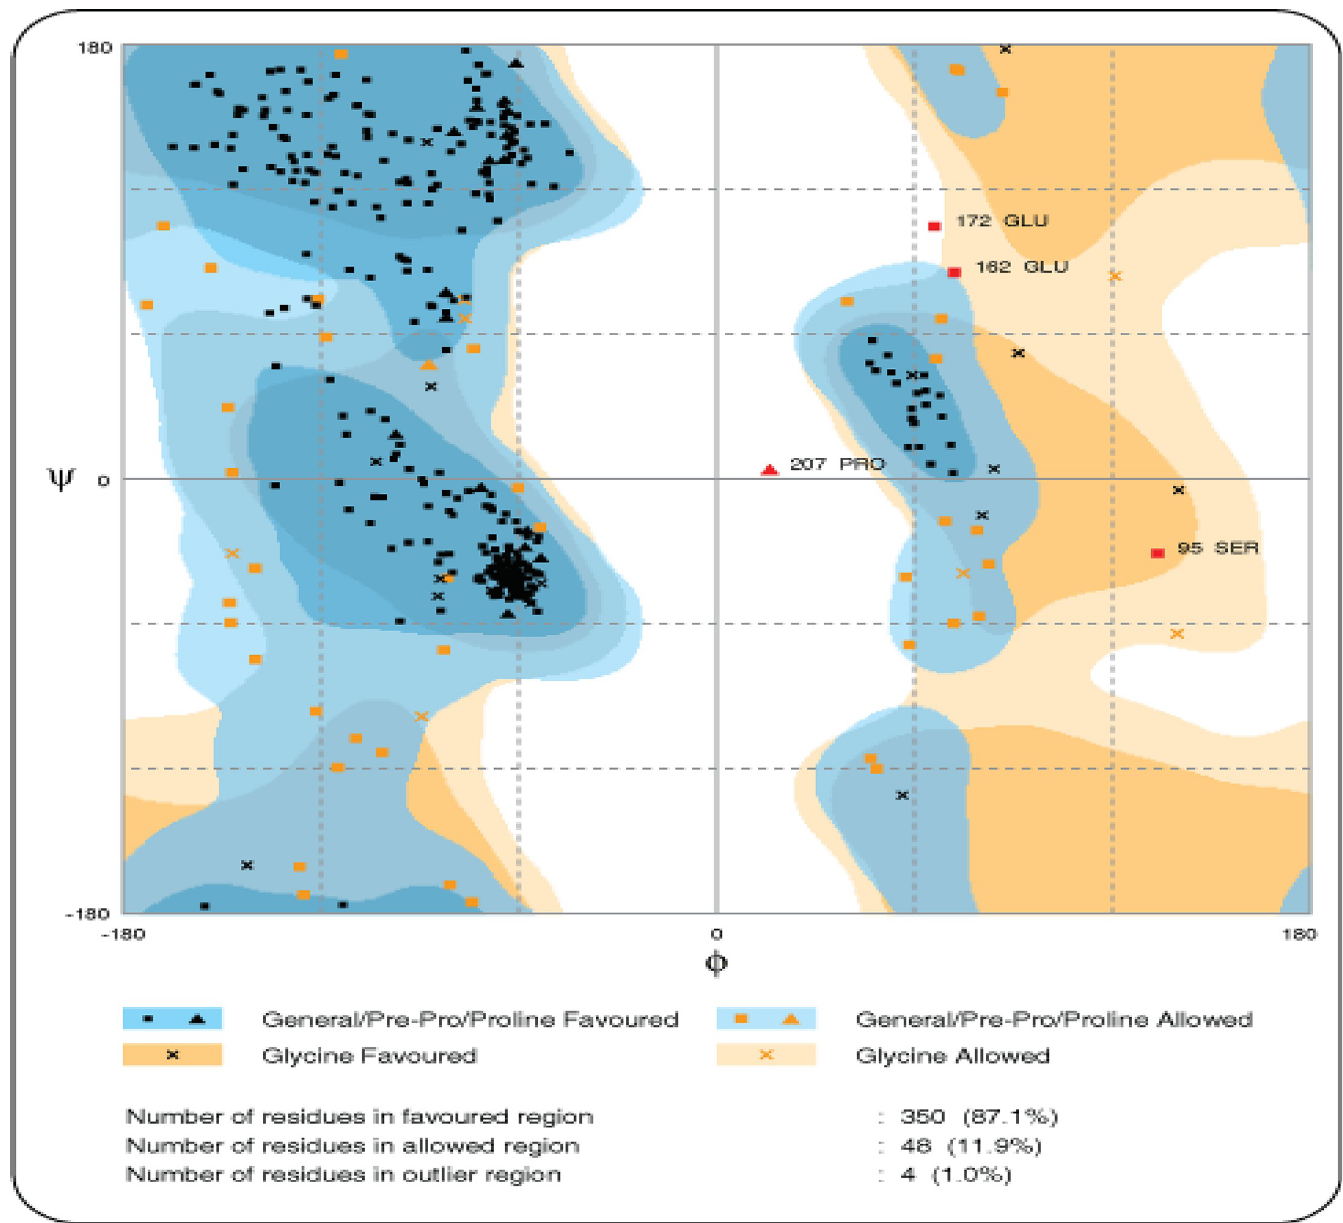
Fig 2. Complete 3D structure simulated by I-TASSER. Complete CD209 structure is colored according to secondary protein structures. In this structure, red color shows the location of alpha-helixes and turquoise of beta-sheets. The one part with yellows color represents the C-Lectin domain involved in ligand binding. https://doi.org/10.1371/journal.pone.0247249.g002 in PCFA2 (best model in ROC) and also predicted pathogenic by all servers. These mutations were W315R, W343G, W260C, P348L, D320Y, G317E, D366A, L318P, G346R and G346E. I-TASSER generated five structures having a C-score (confidence score). C-score is based on the significance of threading template alignments and the convergence parameters of the structure assembly simulations. C-score typically ranges from -5 to 2 and 3D models with low C-score were considered as the best model. Out of five predicted models, a model having C- score -2.51 was selected, and its quality was assessed by ERRAT server. Moreover, I-TASSER